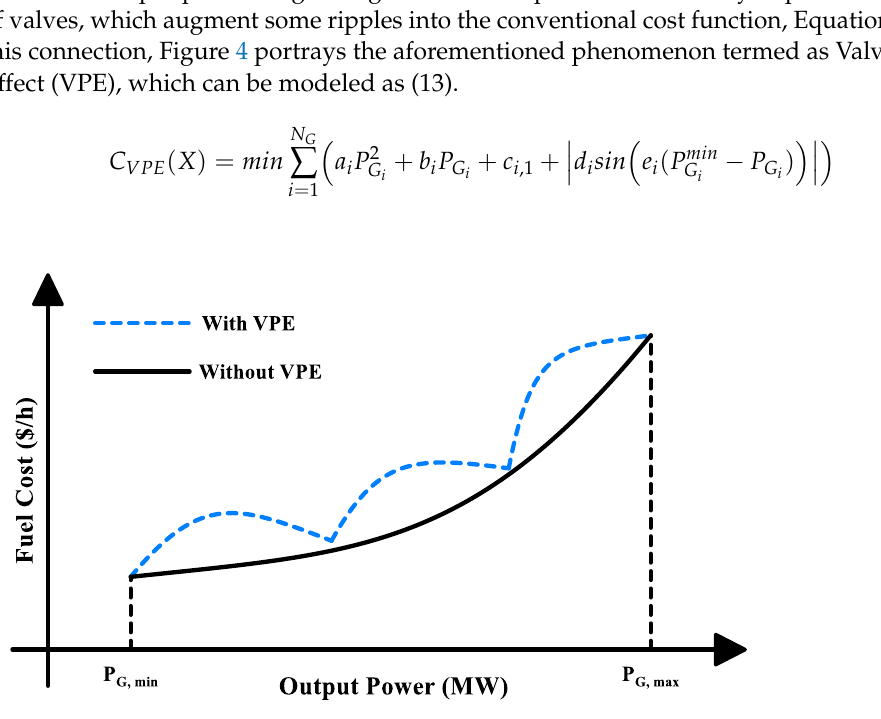
Variables Variable Types State variables